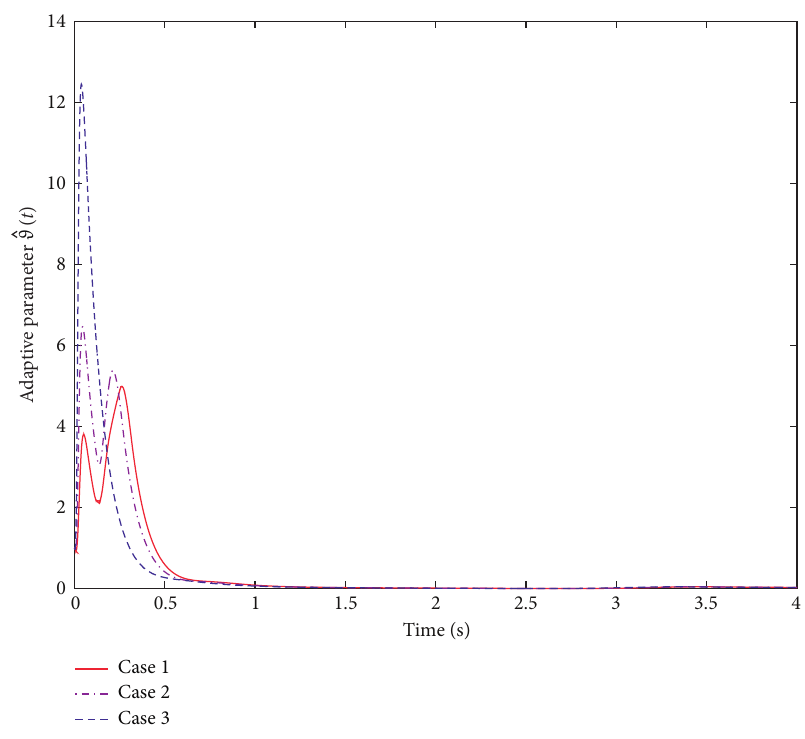
Figure 7: The trajectories of the system state 􏽢 ϑ ( t ) of the proposed method under three